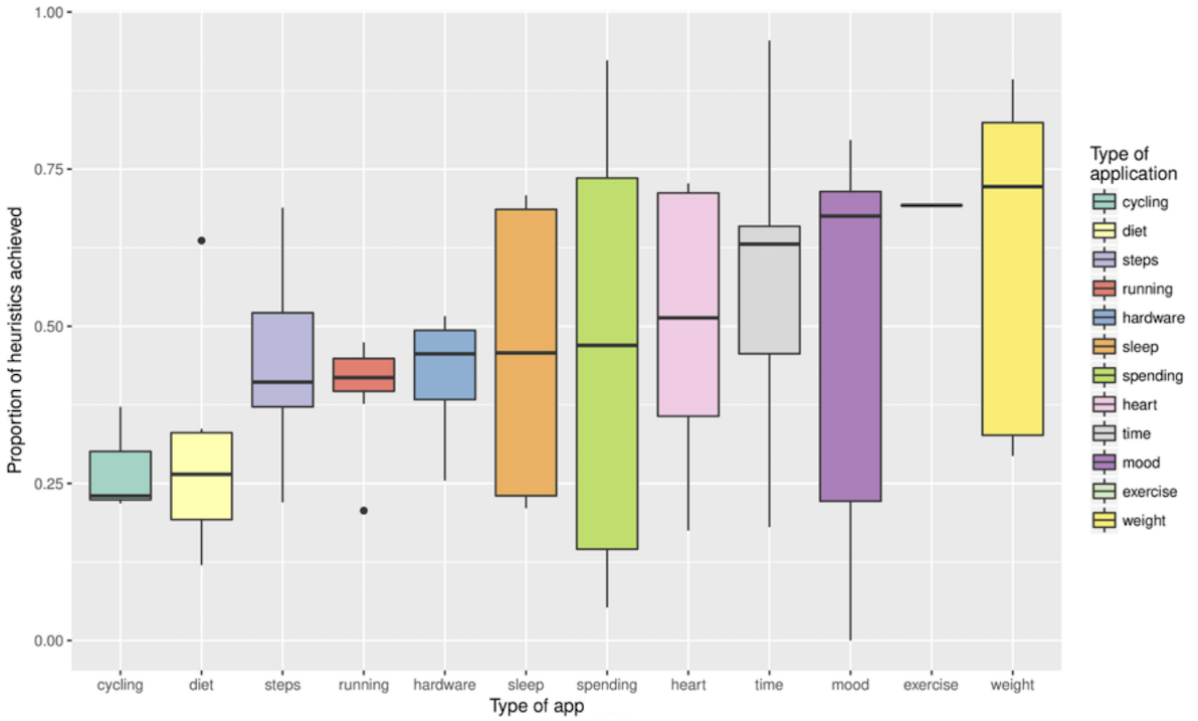
Figure 3. Boxplot showing how performance on the privacy heuristics varies across different types of apps.